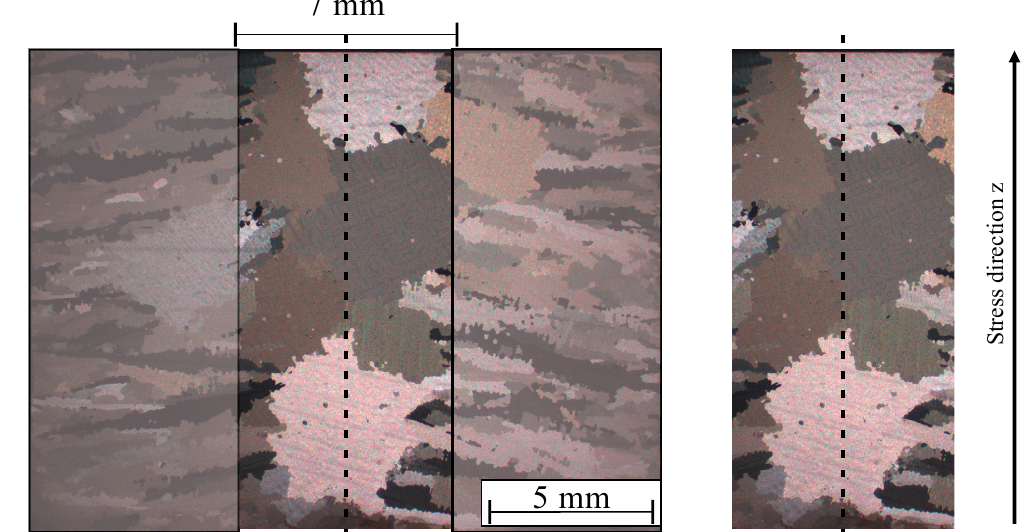
Figure 4. Light microscopy image of the vertical cross section of a 20 mm bar of Ren é 80. Coarse grains with random orientation solidified in the center of the gauge section but also fine, dendritically solidified grains are also visible in the edge area. The right-hand side shows the section that remained after specimen machining.